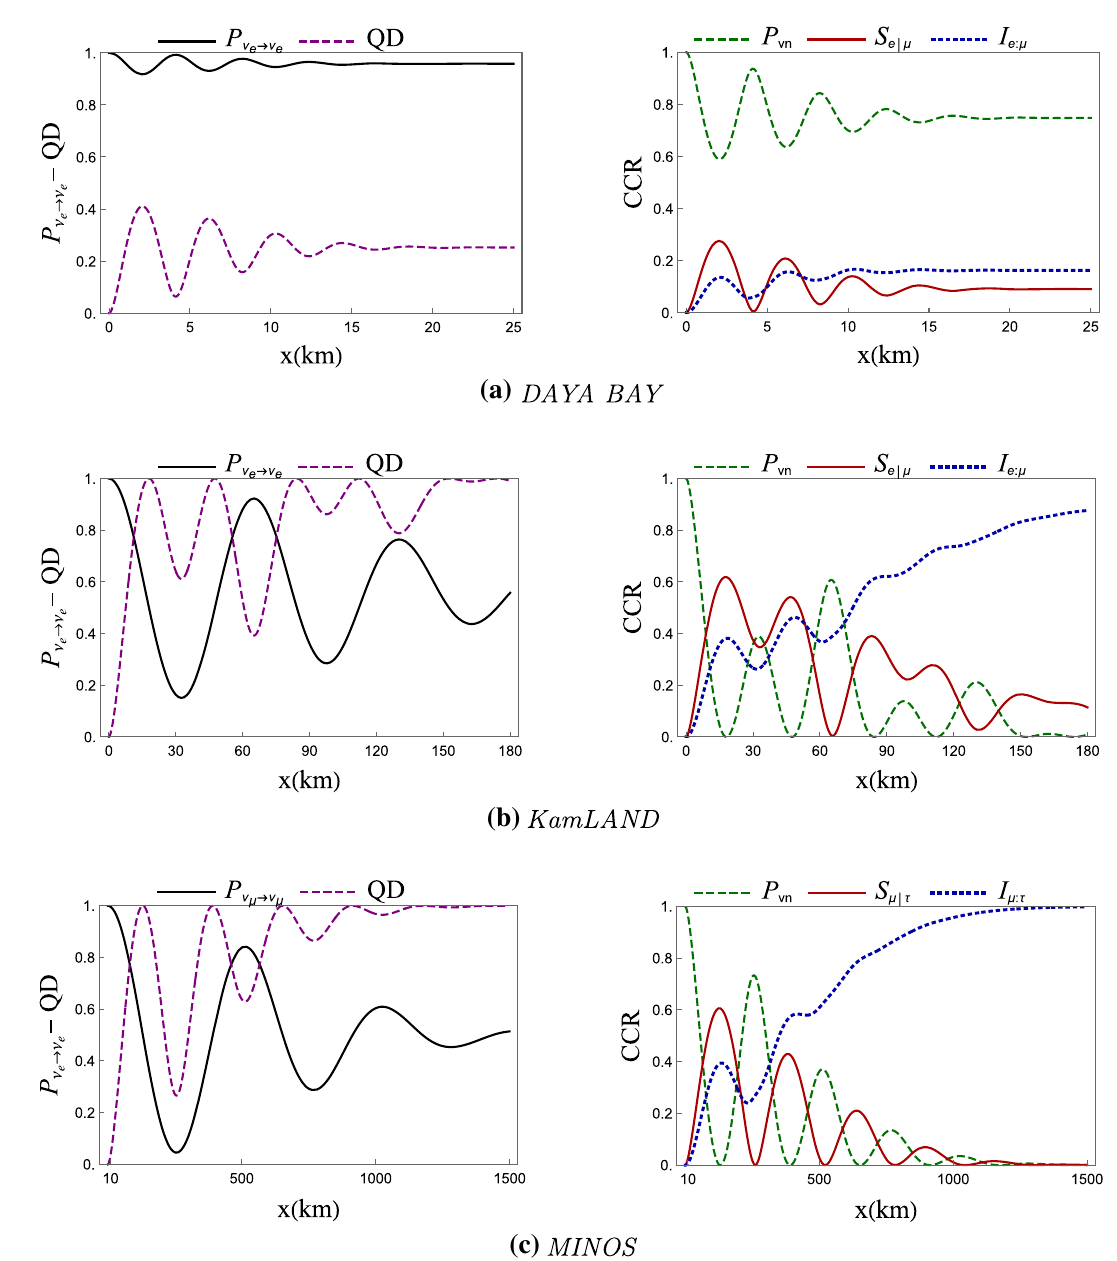
Fig. 1 On the left panels are shown the survival probability P ν α → ν α , (α = e ,μ) , and the quantum discord QD as a function of the prop- agation distance x (km) for a neutrino state (13). On the right panels